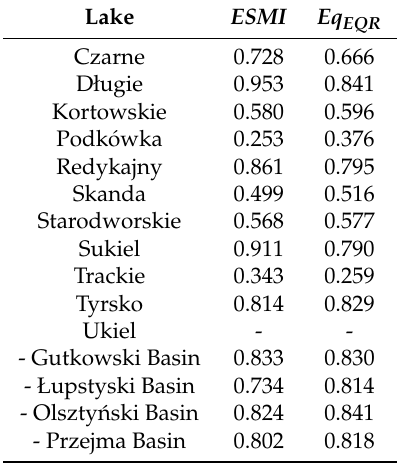
Table 7. Values of the Ecological Status Macrophyte Index ESMI (after Dunalska et al. [19]) and Eq EQR in lakes in vicinity Olsztyn in the growing season of 2016.